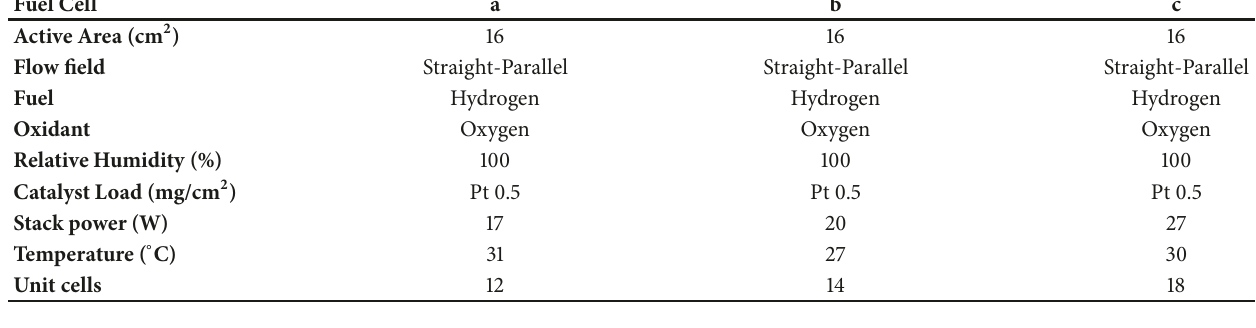
Table 1: Construction and operational parameters of fuel cells presented in Figure 2.